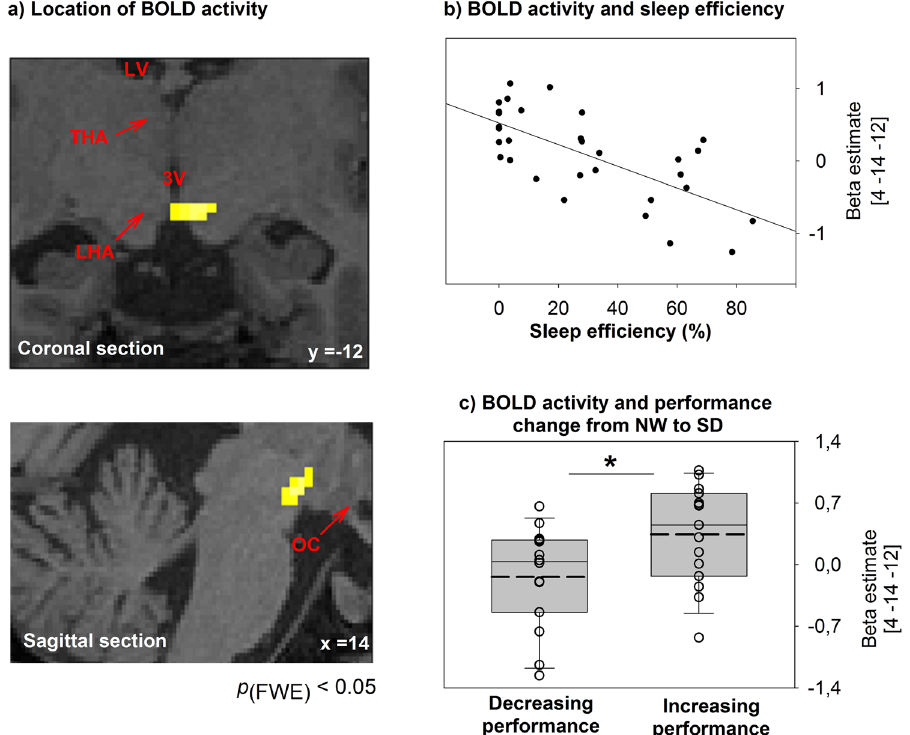
Figure 2. (a) The blood-oxygen-level-dependent (BOLD) hypothalamic signal, covarying with sleep efficiency in the late evening, is plotted on a structural image of a representative participant. BOLD activity was assessed during the late evening after 13 hours of continuous wakefulness. LV: lateral ventricle; THA: thalamus; 3V: third ventricle; LHT: lateral hypothalamus; OC: optic chiasm. (b) Correlation of hypothalamic BOLD activity refers to the ability to initiate and maintain sleep and is considered to reflect wake-promotion strength (i.e., higher sleep efficiency mirrors weaker wake-promotion). (c) Box plots illustrate the median (solid line)